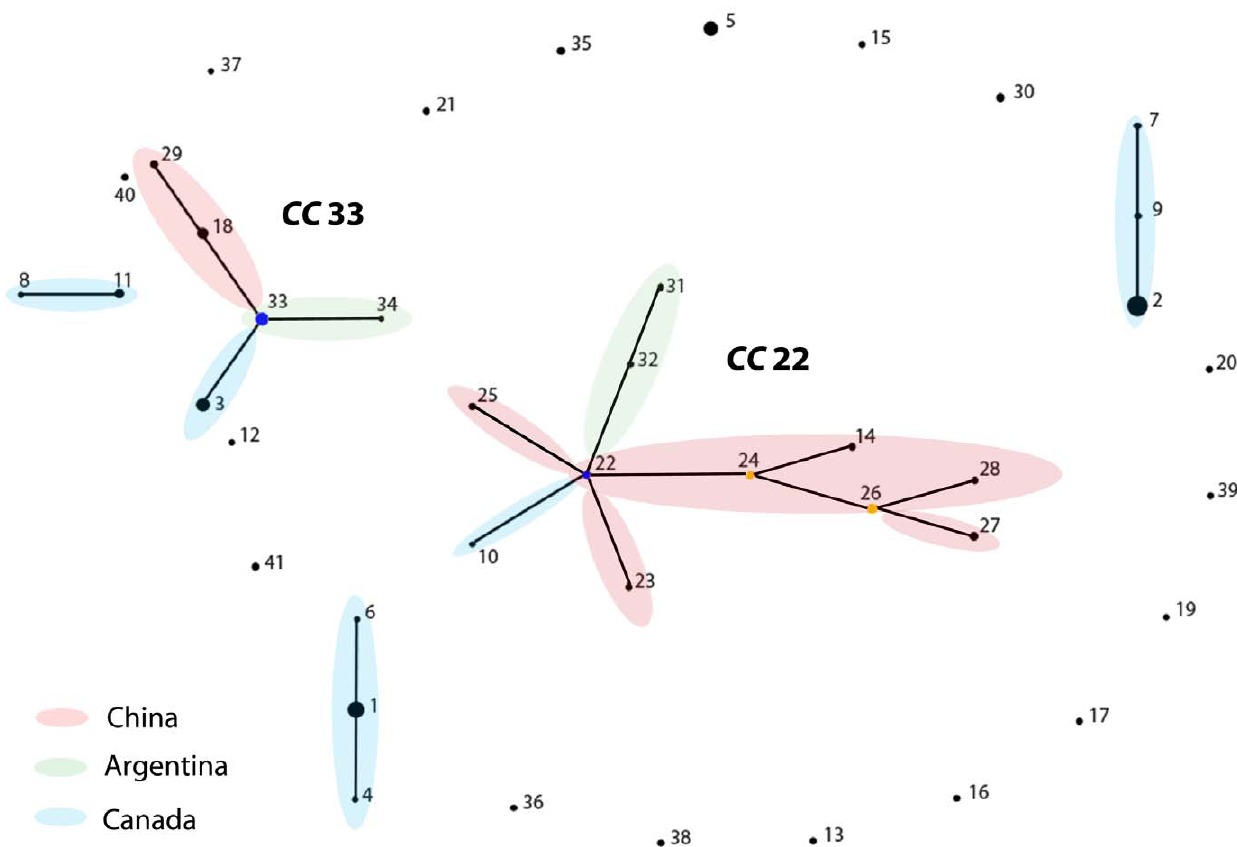
Figure 1. Population snapshot of 80 N. gonorrhoeae isolates from Canada, USA, Argentina, Venezuela, Chile and China as determined by eBURST analysis. Two major clonal complexes (CCs) were found, CC22 and CC33. CC22 consisted of eleven STs, with ST22 being the founder (blue circle) and two STs, ST24, and ST26, being subgroup founders (yellow circle). The CC33 consisted of five STs. Each circle represents a single ST and the size of each dot/circle is proportional to the number of isolates found. Evolutionary related STs were sharing nine out of ten alleles and they are connected by lines. The colored ellipses mark the STs of the same geographic origin.